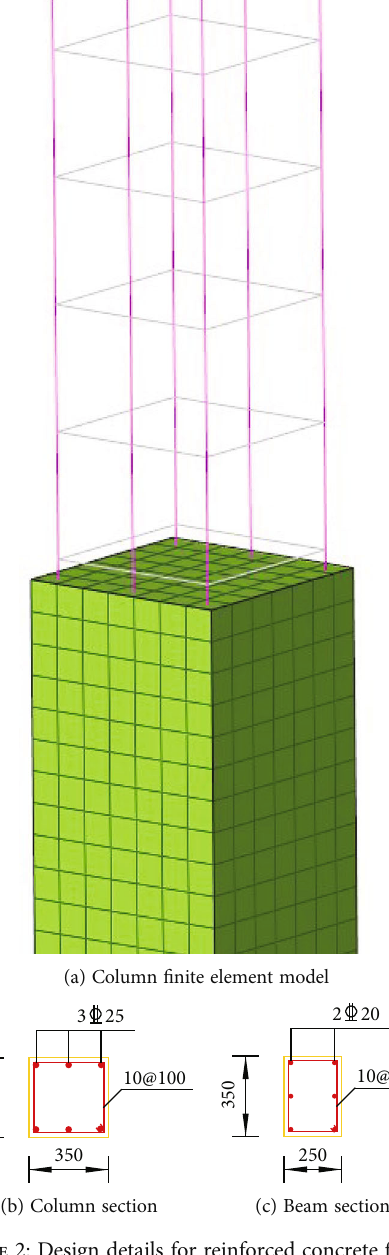
Figure 2: Design details for reinforced concrete